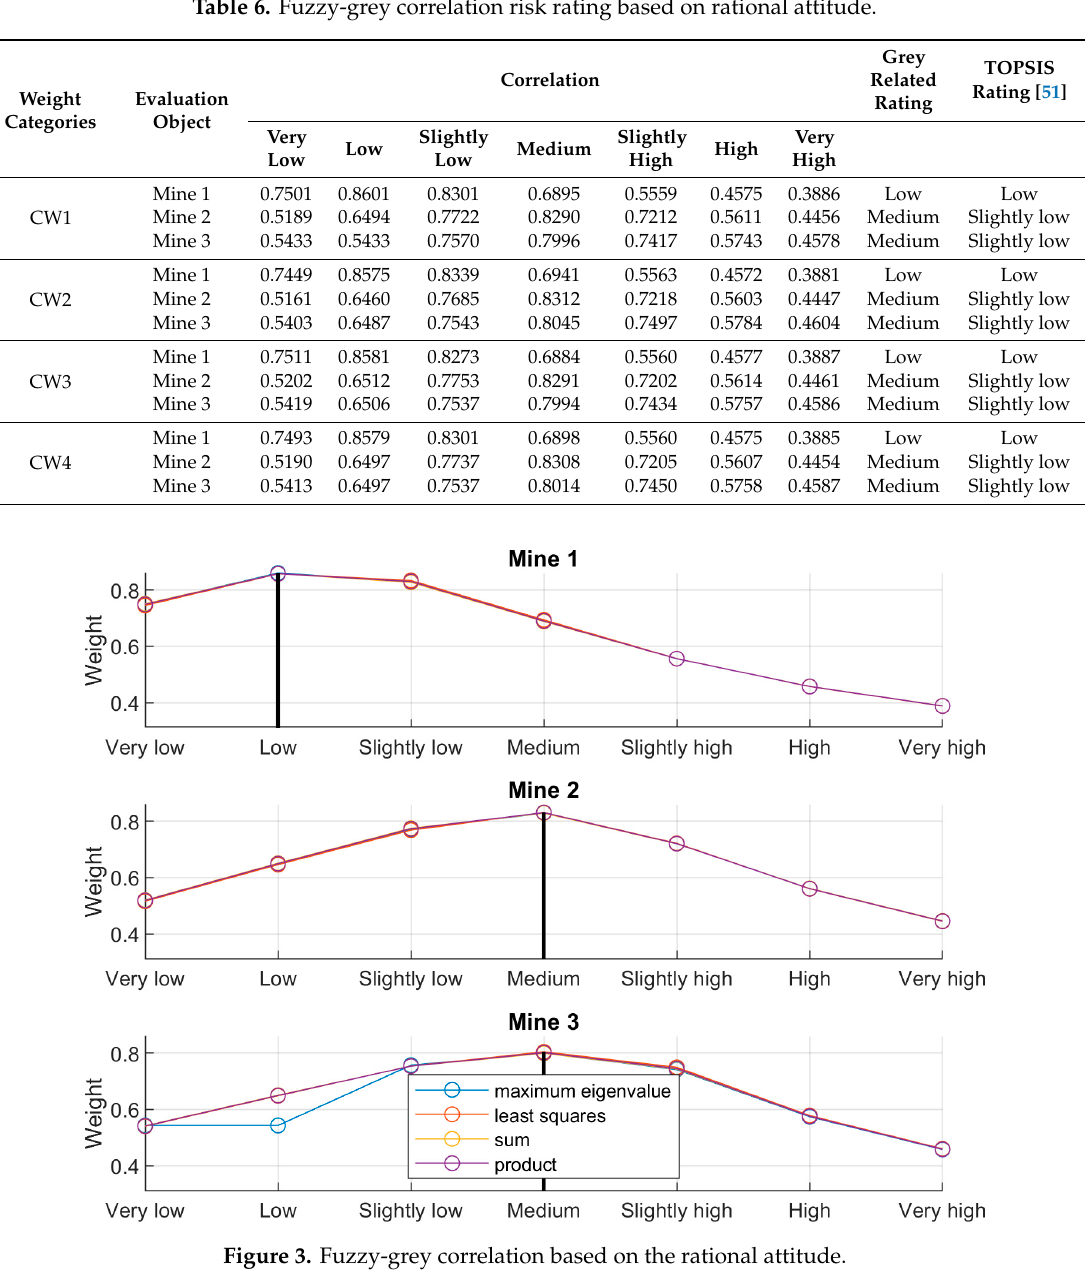
Figure 3. Fuzzy-grey correlation based on the rational attitude.